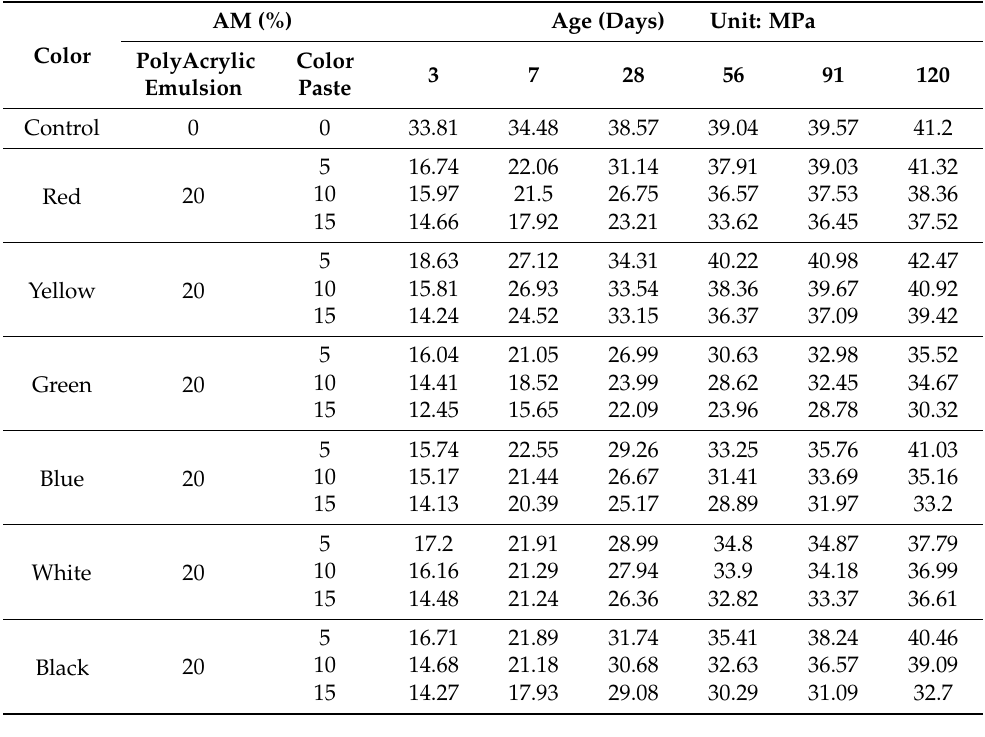
Table 4. Compressive strength of mortar with different proportions of polyacrylic emulsion and inorganic color paste.